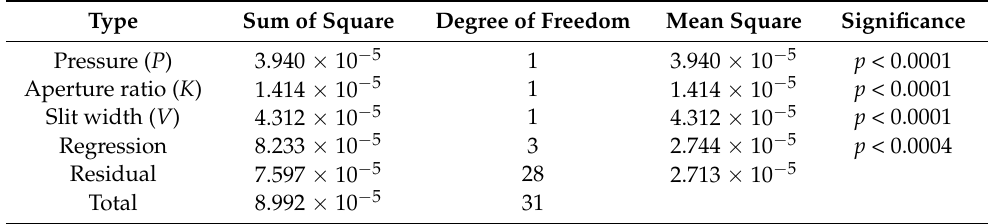
Table 5. Significance analysis of